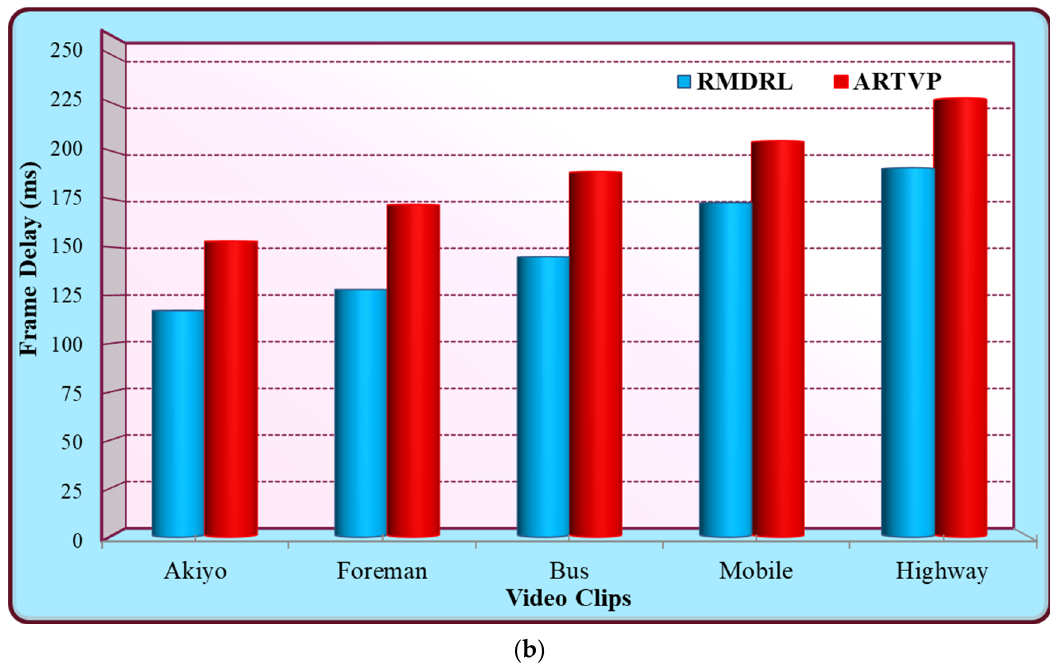
Figure 6. QoE performance for RMDRL and ARTVP: ( a ) PSNR; ( b ) Frame delay.